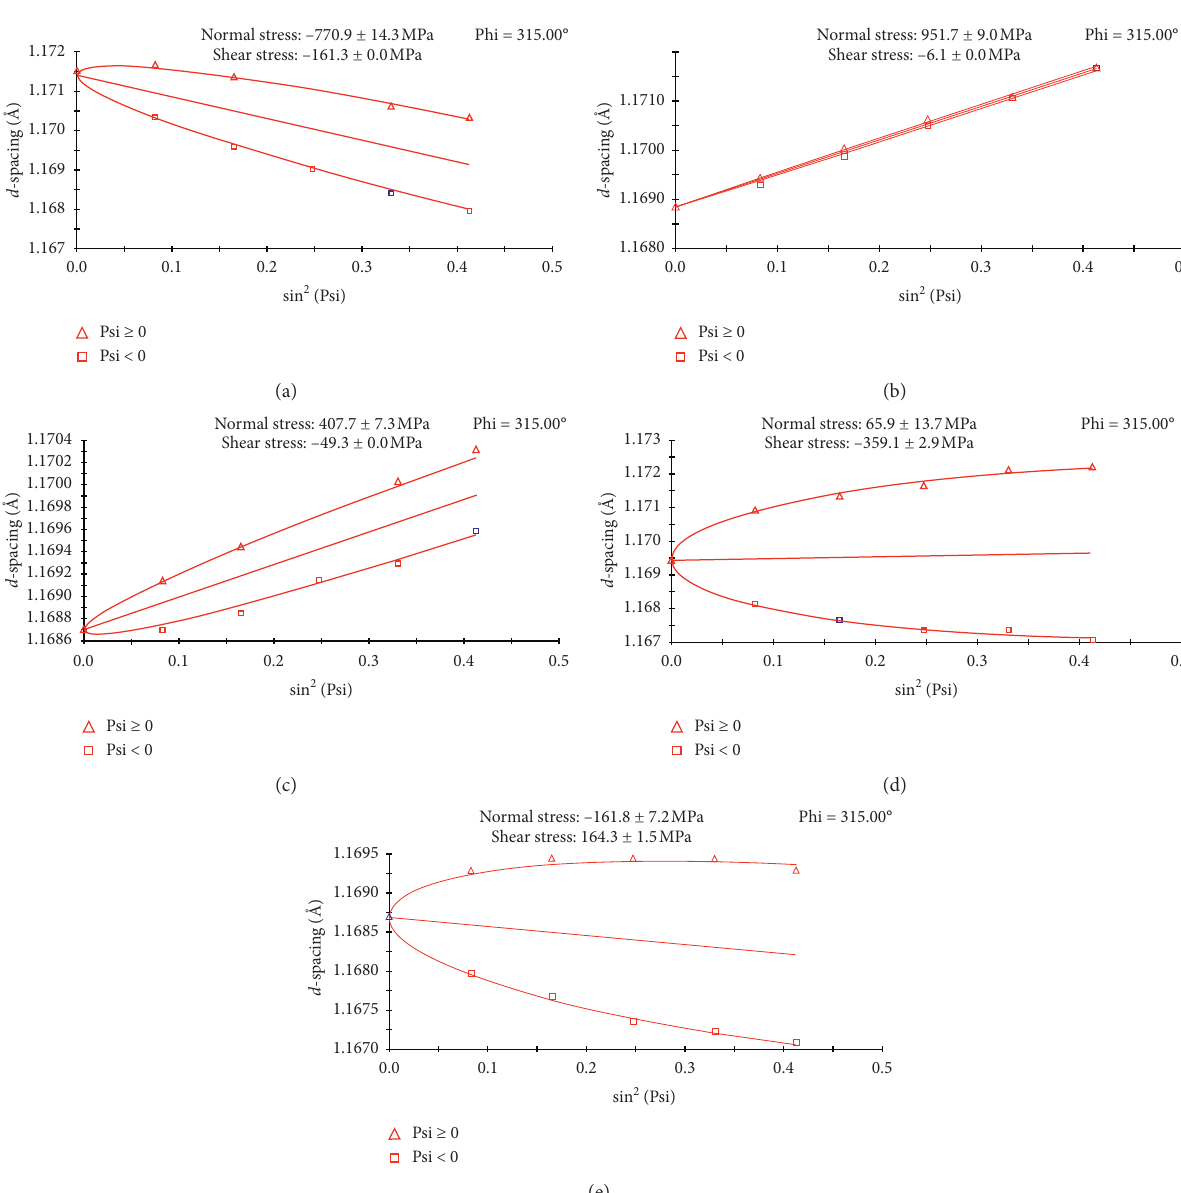
Figure 10: XRD Analysis using d - spacing vs. sin 2 ψ plots for all near-dry machining environments at Vc: 200m/min and f: 0.2mm/rev. (a) Before machining; (b) dry machining environment; (c) CCAVT machining environment; (d) MQCL machining environment; (e) Hybrid NF-MQCL machining